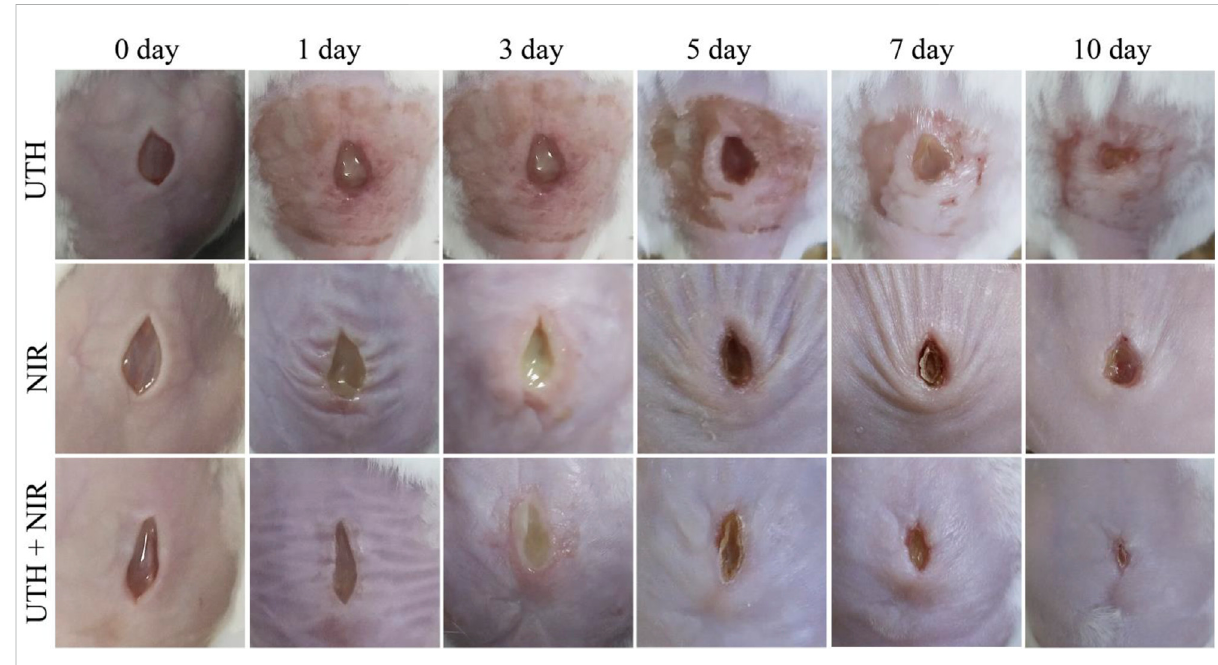
FIGURE 5 Therapeutic effect against mouse wound infection (caused by S. aureus ) under different